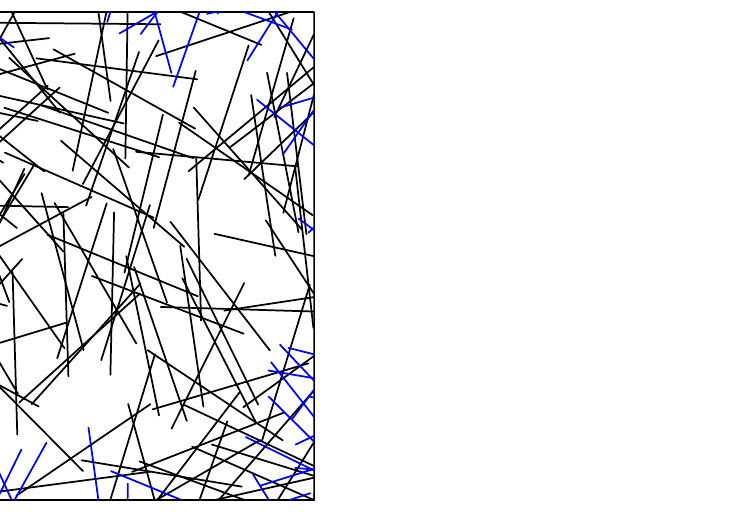
Figure A2. A schematic diagram of the 2D uniformly random nanofiber network after the Figure A2. periodicity process.